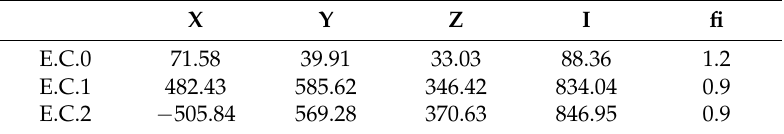
Table 1. External camera correspondence